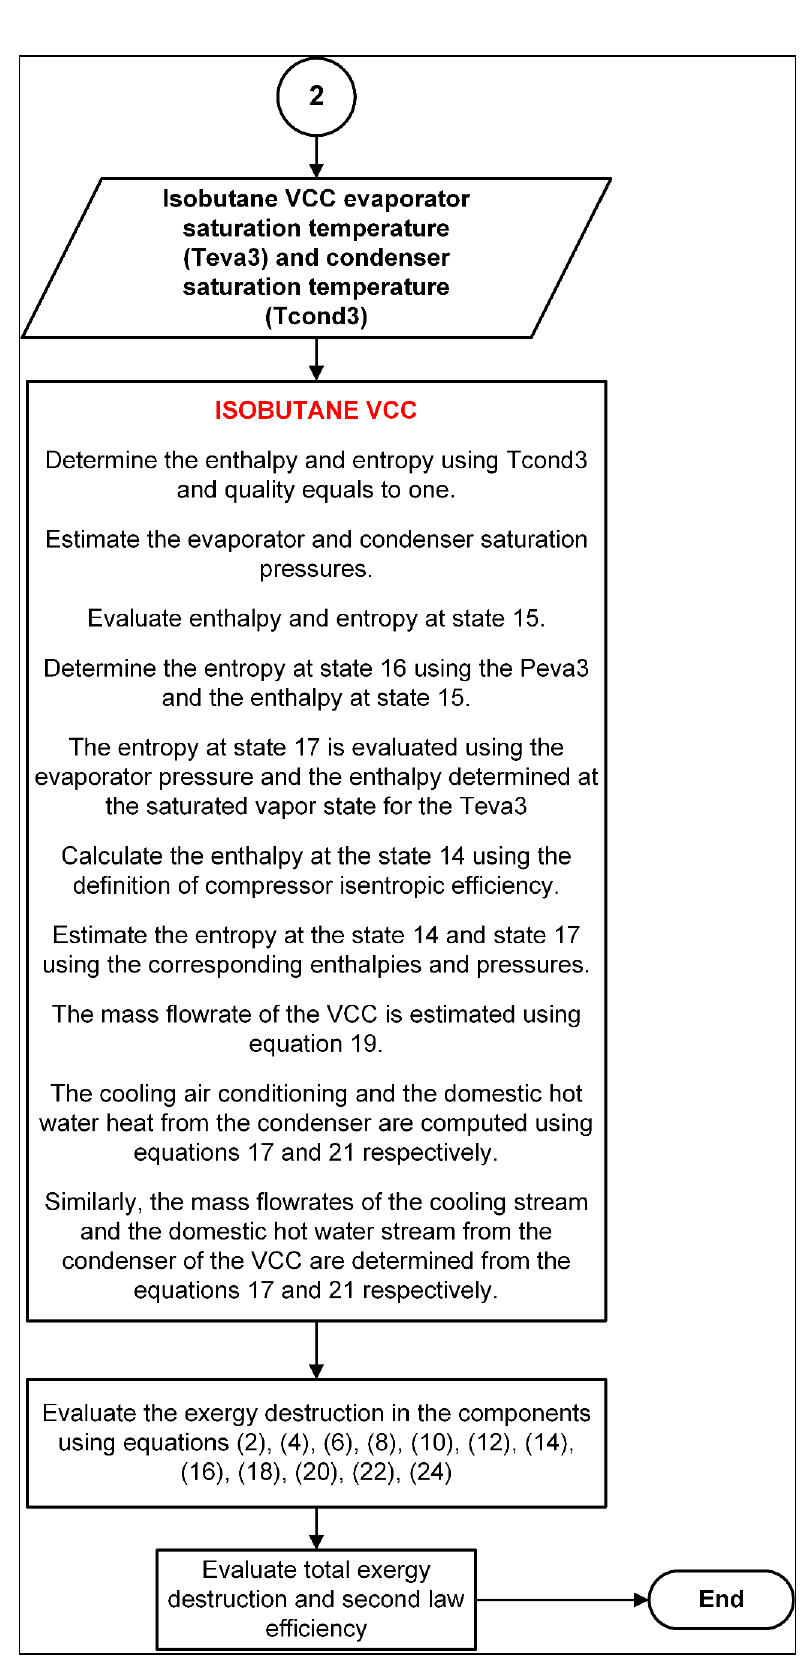
Figure 3. Algorithm for the evaluation of the properties for the complete trigeneration system.